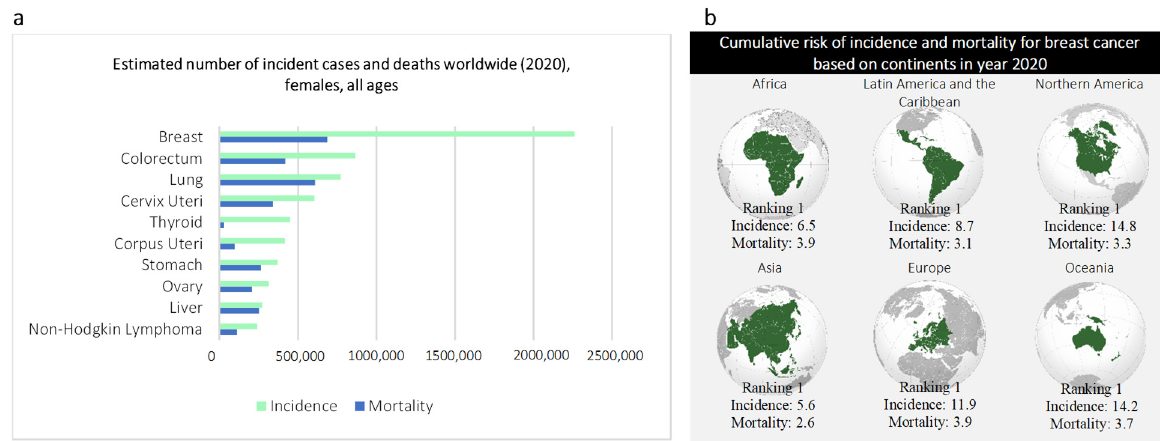
Figure 1. Breast cancer statistics as of 2020 [3]. ( a ), estimated number of incidence cases and deaths worldwide in year 2020 (females, all ages). ( b ), Cumulative risk of incidence and mortality for breast cancer based on continents in year 2020.